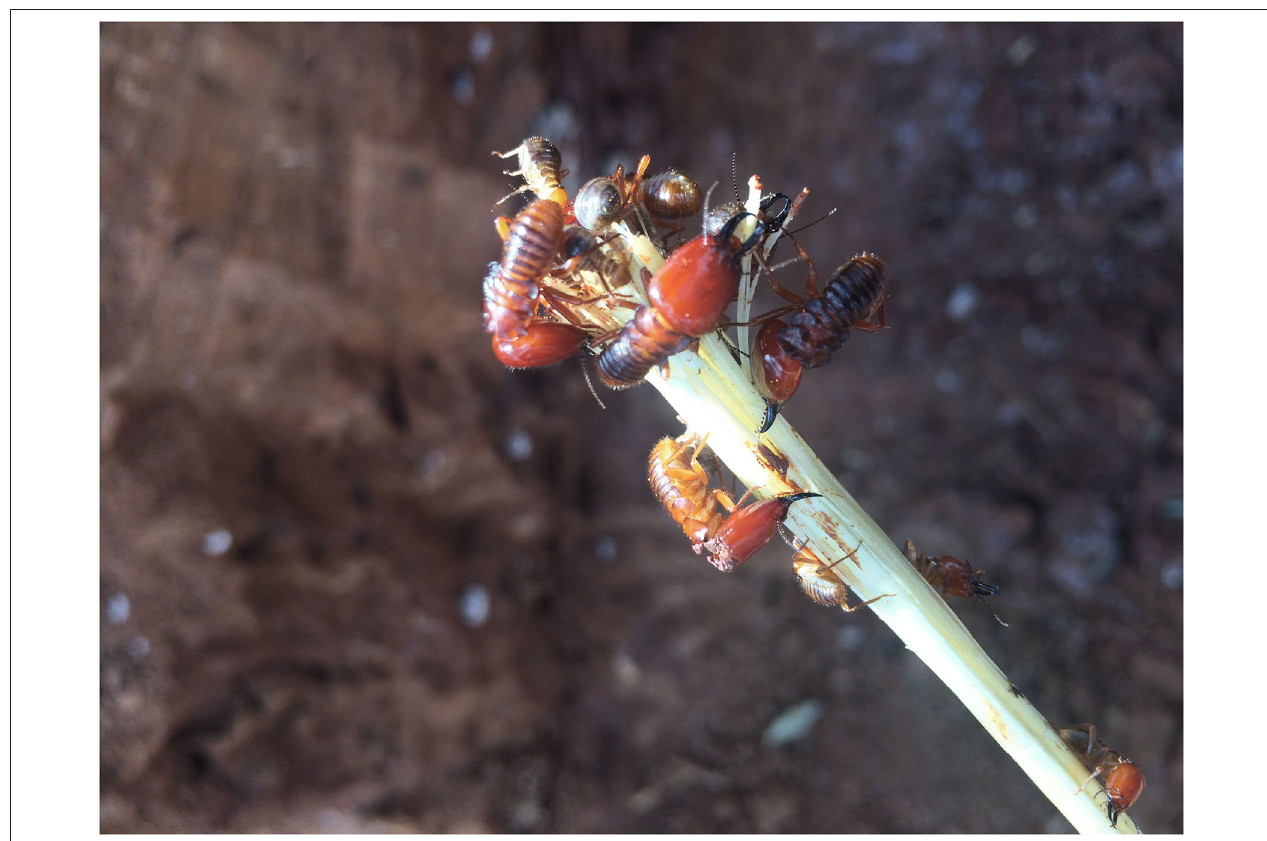
FIGURE 1 | Soldier termites ( Macrotermes natalensis ) are harvested using succulent grass rods. As soldiers attack to defend the nest from perceived intrusion by the grass rod, their mandibles become entrapped on the succulent grass rod and to their doom. This method is selective to soldier